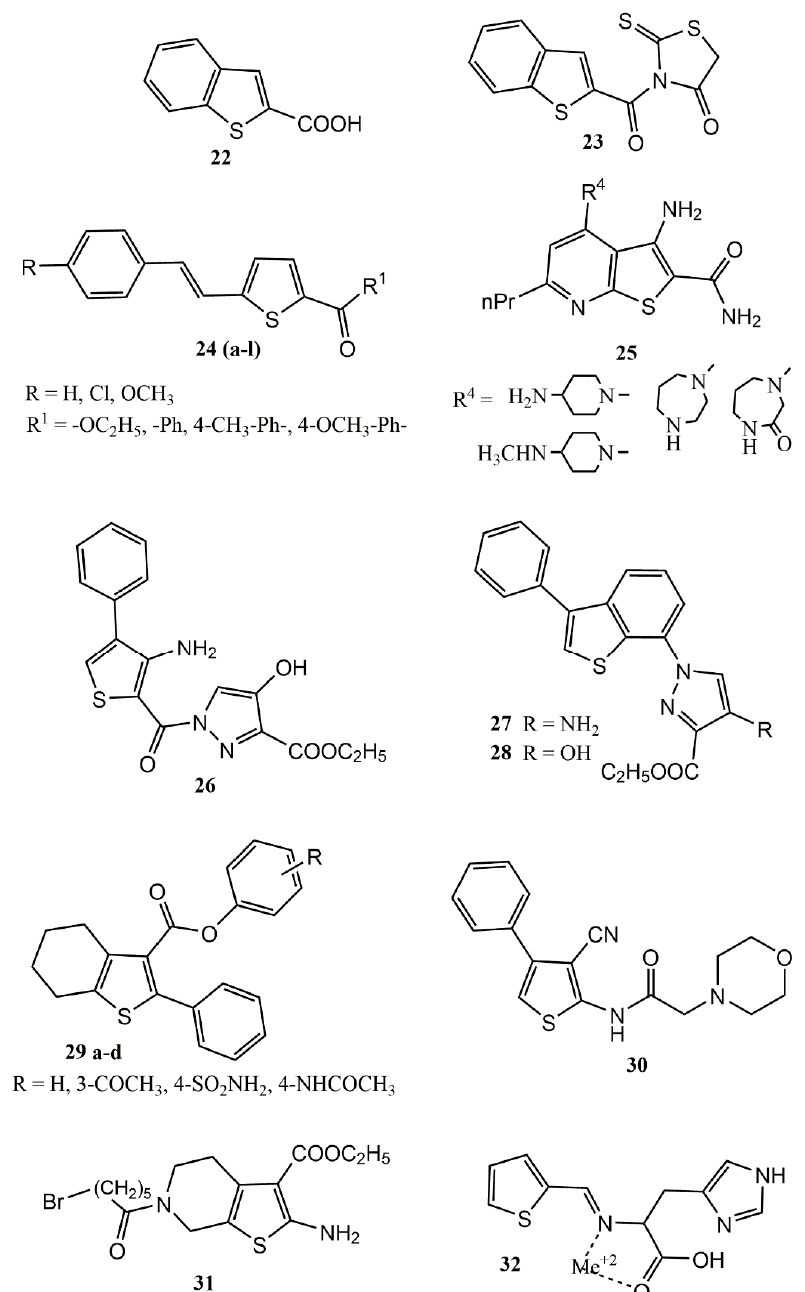
Figure 6. Chemical structures of thiophene-based compounds with anti-inflammatory properties in in silico studies.